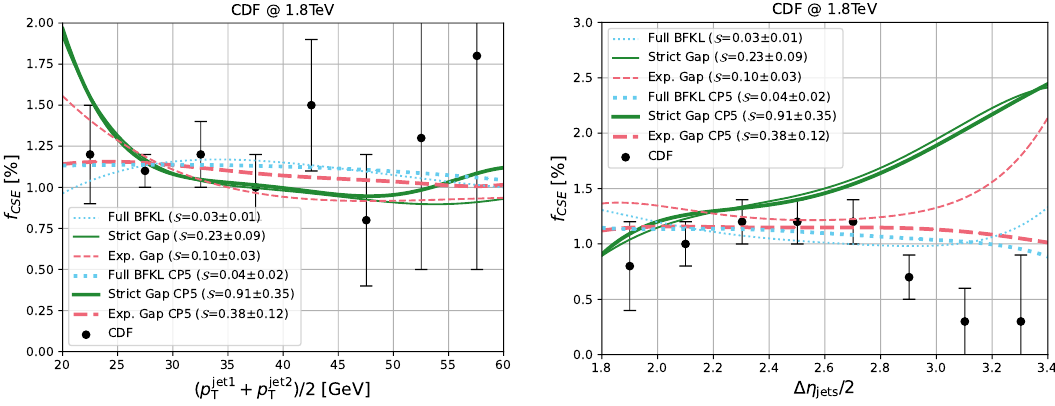
Figure 3 . Predictions for f CSE as a function of the average jet p T (left) and ∆ η jets / 2 (right) compared to the CDF measurement at 1.8 TeV [10] for three different gap definitions (different line shapes), using the modified tune CP1 (with rapidity ordering, without MPI, thin lines) and the tune CP5 (with rapidity ordering, with MPI, thick